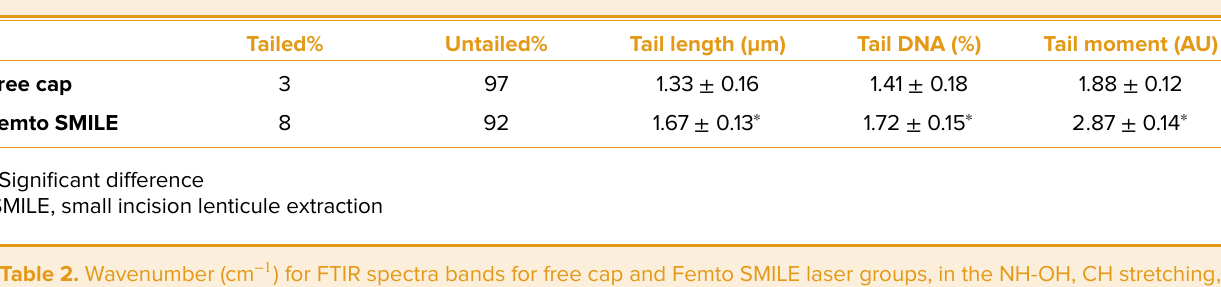
Table 1. Tail length, tail DNA (%), and tail moment for free cap group and Femto SMILE group obtained by comet assay images analysis.